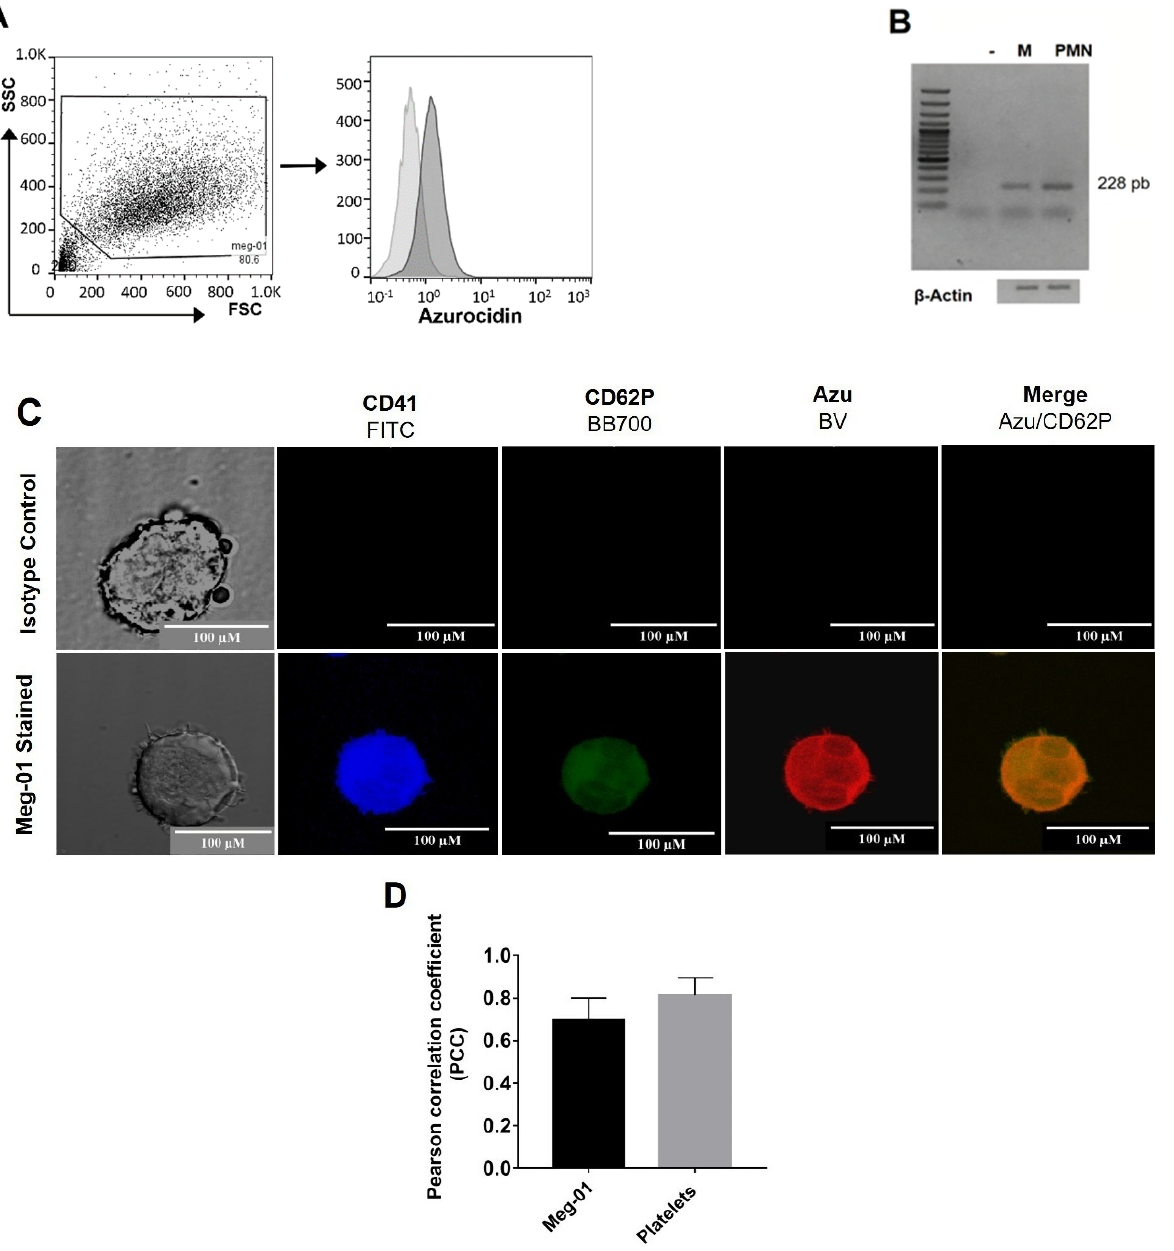
Figure 2. Meg − 01 cells express azurocidin. ( A ) Intracellular staining for azurocidin was performed in the Meg-01 cell line using a specific mAb and analyzed by flow cytometry. In the figure, it is depicted in a dark gray histogram, while the light gray histogram indicates staining with the isotype control mAb. ( B ) Total RNA from Meg-01 cell cultures was extracted and analyzed for azurocidin expression by RT-PCR, amplicons of the expected size (228 bp) from cell line (M) and peripheral blood polymorphonuclear leukocytes (PMN) were resolved on 2% agarose gels, β − actin expression was used as housekeeping control. Both ( A , B ) data are representative of five independent experiments. ( C ) Confocal microscopy of Meg-01 cells, stained intracellularly with mAbs against CD41 (blue), CD62P (green), and azurocidin (red). Scale bar equals 100 µ m (representative images of 3 independent assays). ( D ) The graphs show the averages ± SD of the Pearson correlation coefficient (PCC) value obtained for each image after background correction in the Regions of Interest (ROI) in five selected areas per slice of the co-localization visualized between CD62P and Azurocidin from 3 independent assays and analyzed with the Coloc-2 co-localization plug-in of FIJI.